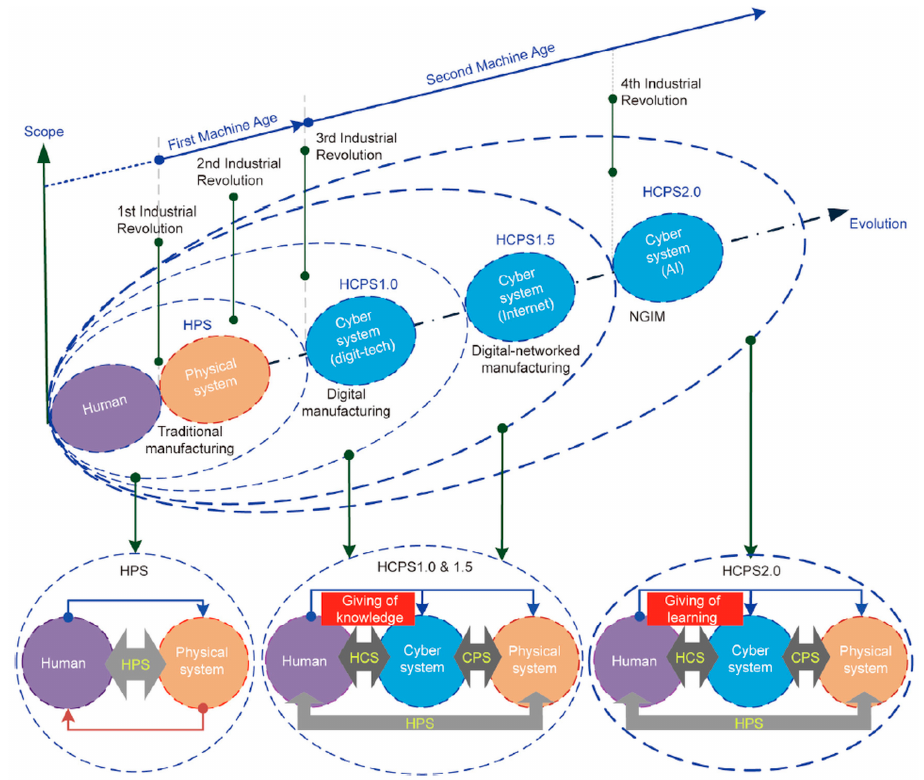
Figure 3. Intelligent manufacturing evolution (Reprinted from Ref. [29]).